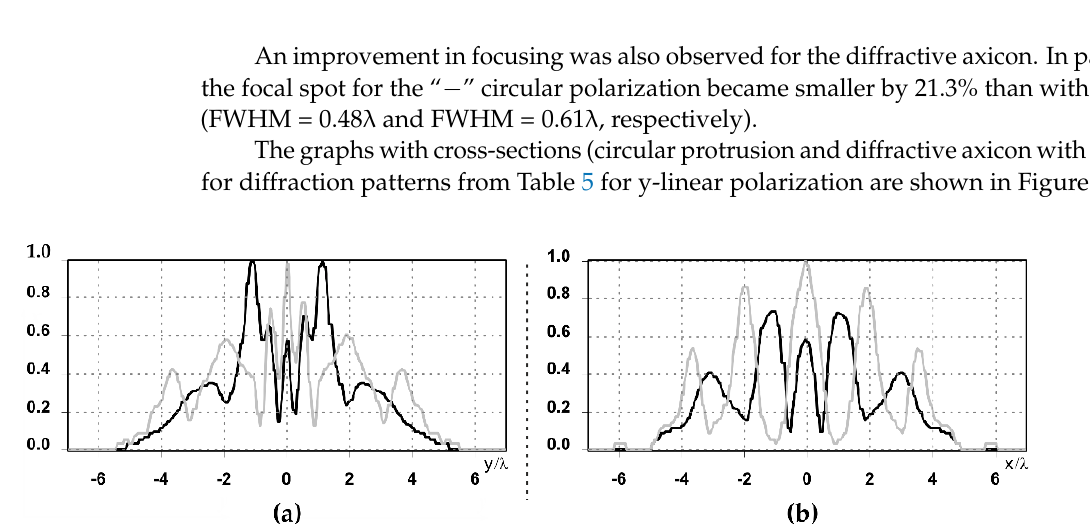
Figure 7. The cross sections for the cases in Table 5, circular protrusion with r = 2.0 λ (black line) and diffractive axicon with NA = 0.25 (gray line), y-linear polarization ( a ) along the narrow part of the focal spot and ( b ) along the wide part of the focal spot.